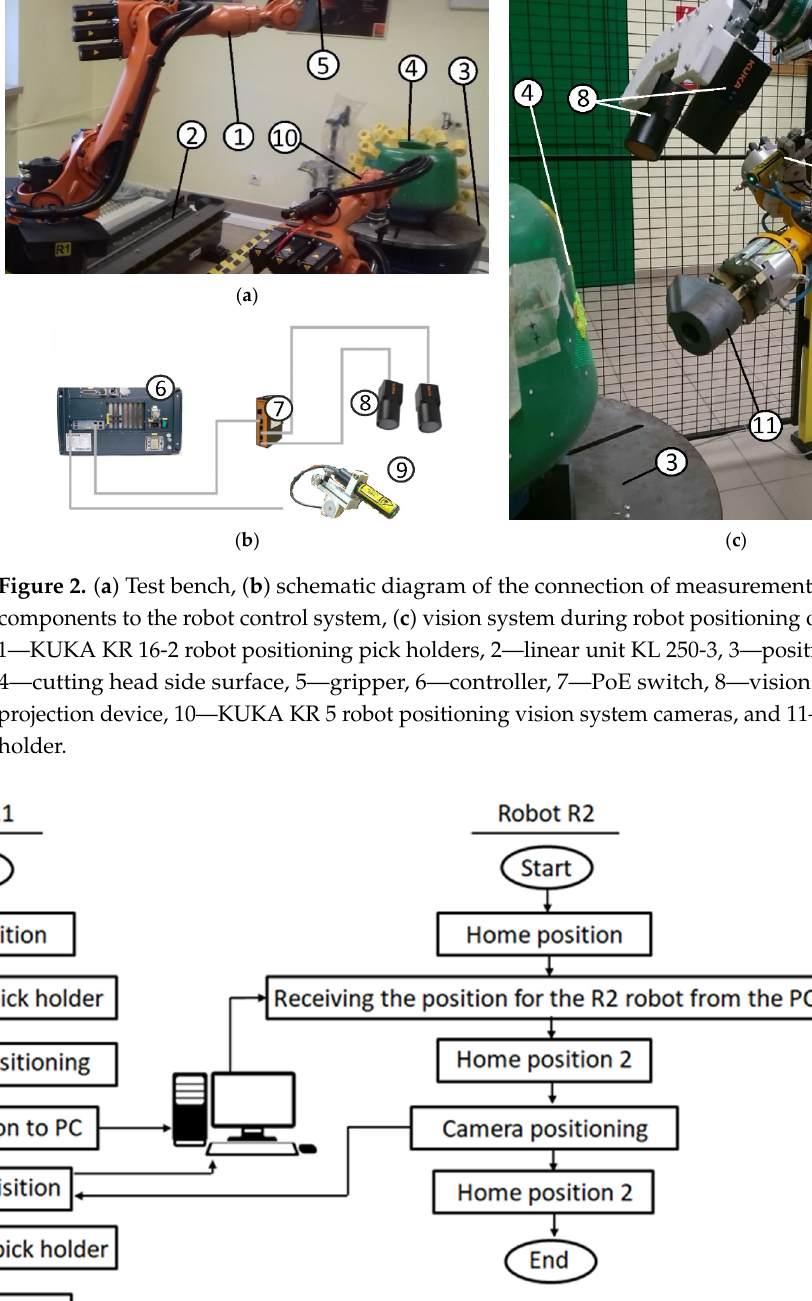
Figure 3. The simplified algorithm for controlling the robots during measurement.